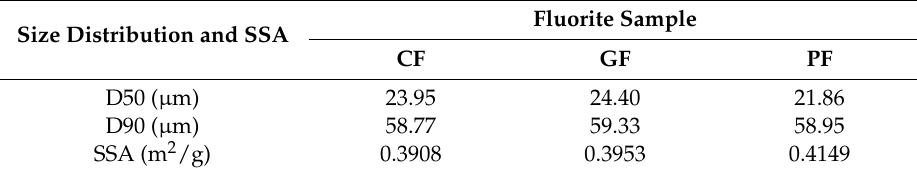
Table 1. Particle size analysis and specific surface area of fine fluorites with different colors. Size Distribution and SSA